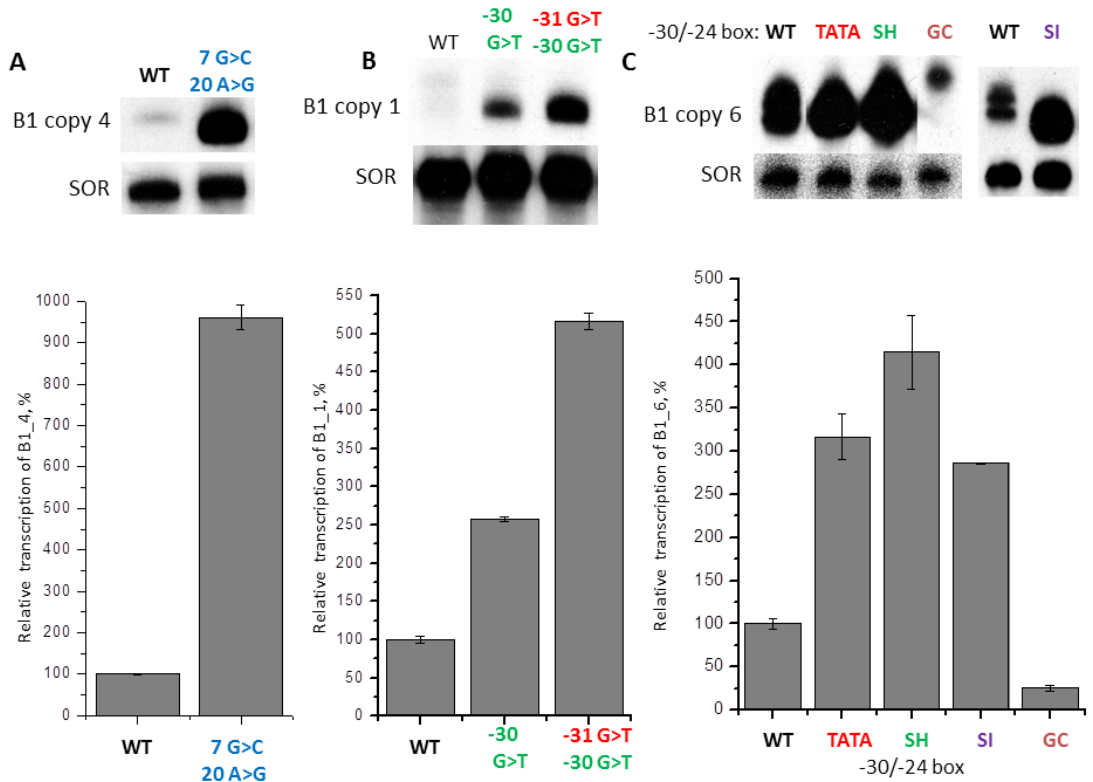
Figure 8. ( A ) B1_4 transcription increases after two substitutions at the beginning of SINE, including A to G replacement in box A of pol III promoter (error bars, SD, n = 3). ( B ) B1_1 transcription increases after G to T replacements at positions − 30 and − 31. The transcription level of B1 with the original 5 (cid:48) -FS (WT) is taken as 100% (error bars, SD, n = 3). ( C ) B1_6 transcription is modulated by replacement of − 30 / − 24 sequence by TATA box, − 30 / − 24 boxes of genes 4.5SH RNA and 4.5SI RNA, and GC-rich heptamer. The transcription level of B1_6 with the intact 5 (cid:48) -FS (WT) is taken as 100% (error bars, SD, n =